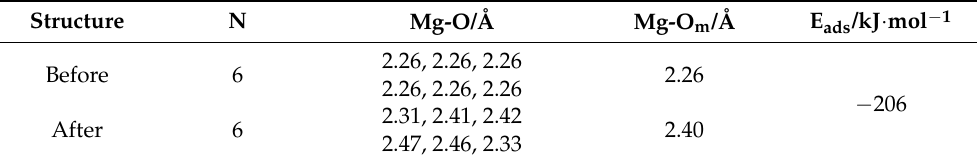
Figure 5. Equilibrium geometry of [Mg(H 2 O) 6 ] 2+ adsorbed on the (001) surface of Mt. Table 5. Adsorption energy and structural parameters of [Mg(H 2 O) 6 ] 2+ adsorbed on the (001) surface of Mt.